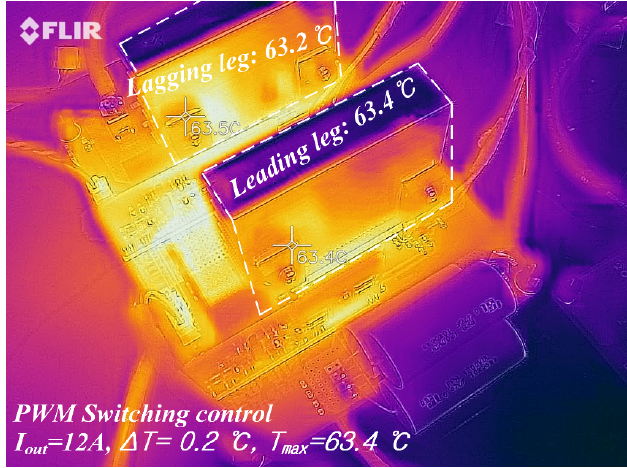
Figure 11. Heat measurement of the PSFB converter using a general PWM switching control.